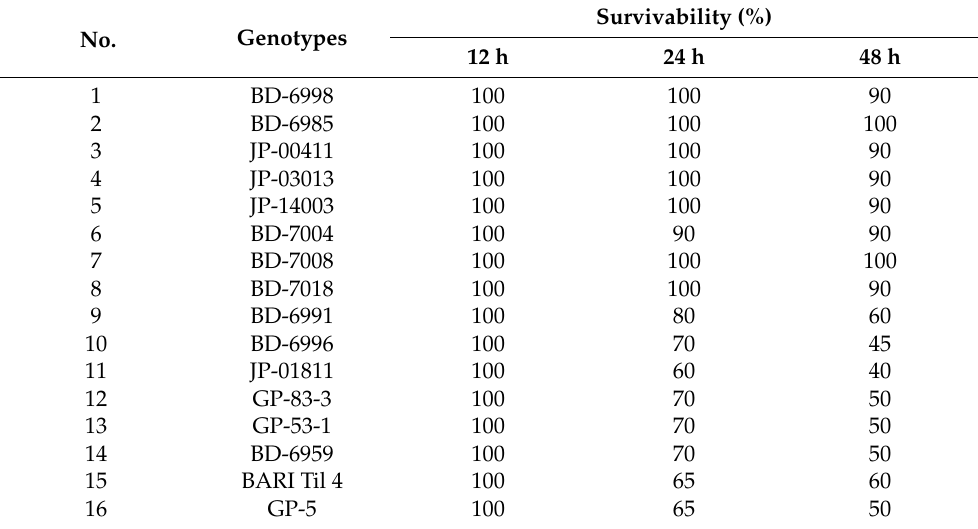
Table 4. Pattern of survivability percentages of sixteen sesame genotypes in waterlogged conditions at 12, 24, and 48